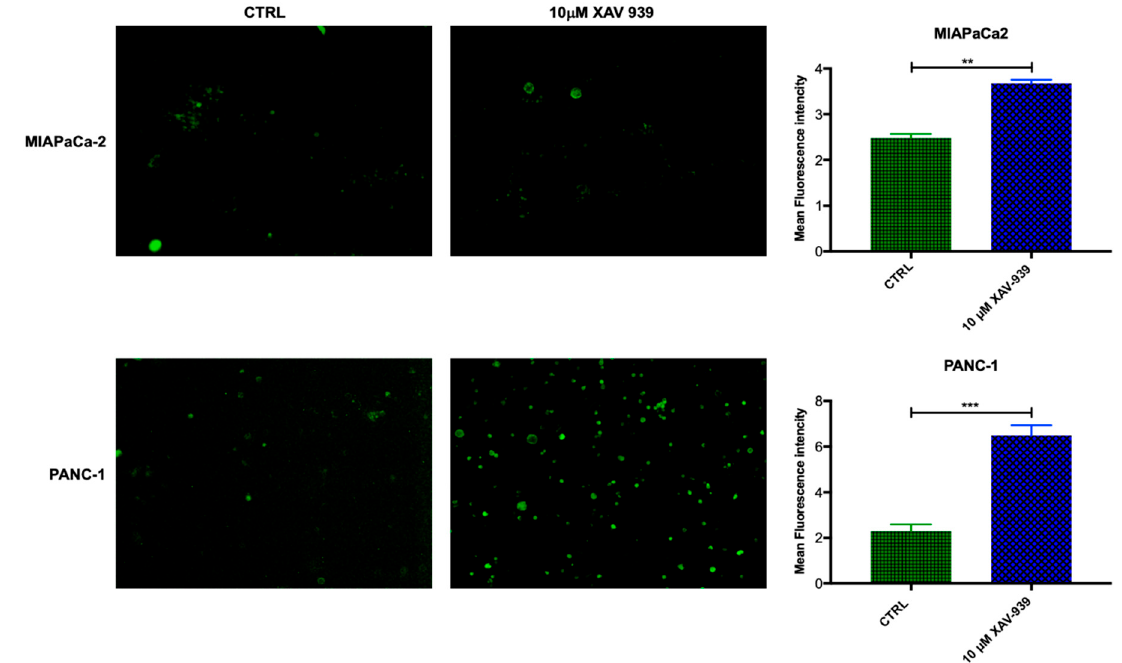
Figure 9. Immunofluorescent detection of CD40 in mDCs kept in contact with PDAC cells (MiaPaCa-2 in the upper panel and PANC-1 in the lower one) and XAV-939 (10 µM). The specimens were examined using a Leica (DMi8) immunofluorescence microscope. The images reported were recorded with 20× magnification and the quantification of the immunofluorescence was performed by ImageJ software.